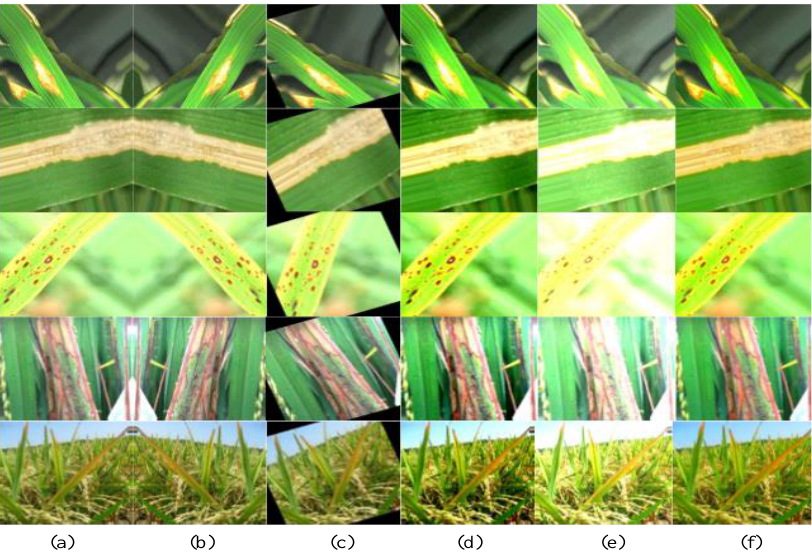
Figure 7. Data enhancement example: ( a ) original image; ( b ) flip; ( c ) rotation; ( d ) contrast enhance- ment; ( e ) brightness enhancement; and ( f ) color enhancement.